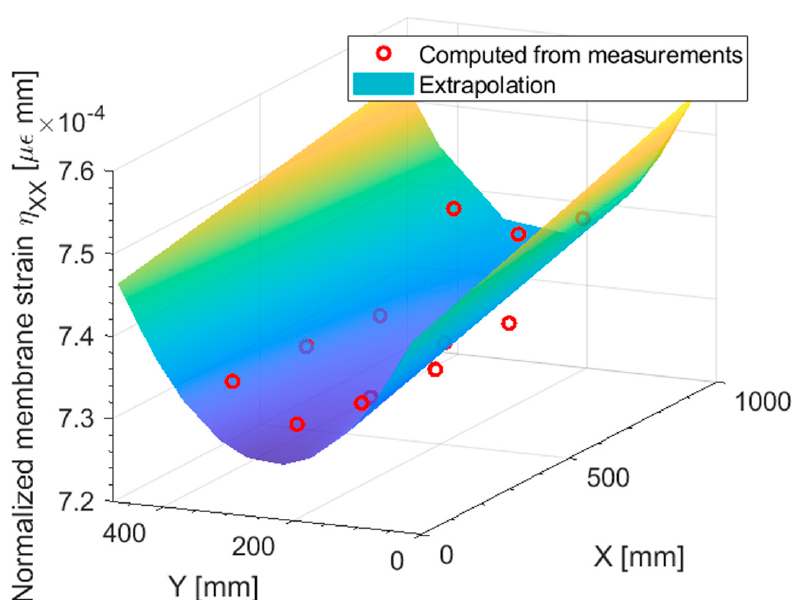
Sensors 2023 , 23 , x FOR PEER REVIEW Figure 6. Traction: normalized membrane strain 𝜂 (cid:3025)(cid:3025) pre-extrapolation. Figure 6. Traction: normalized membrane strain η